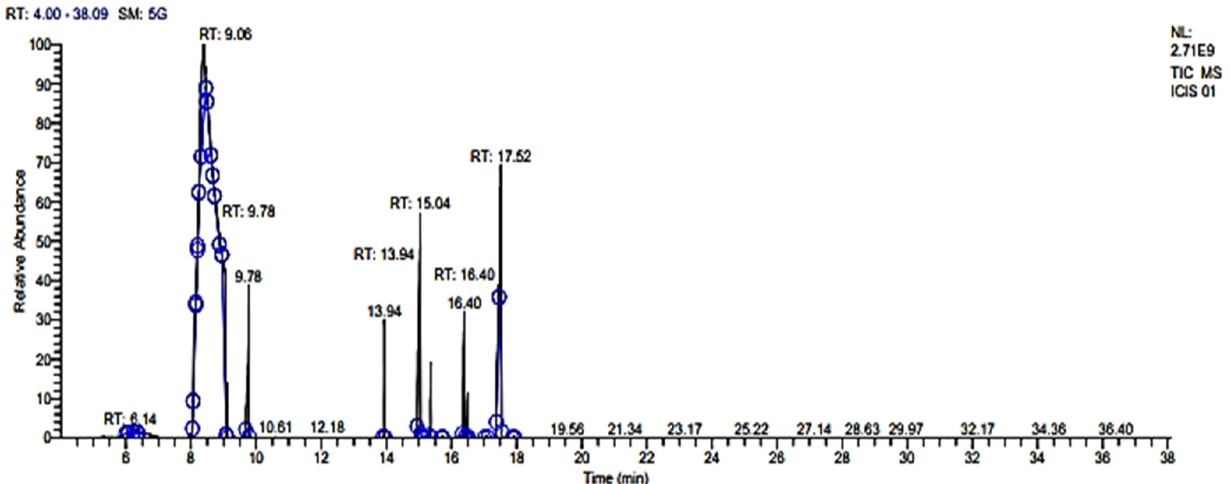
Figure 1. Chemical composition of CLO through GC–MS. Phytoconstituents were identified through different time interval and recorded in terms of retention time (RT).